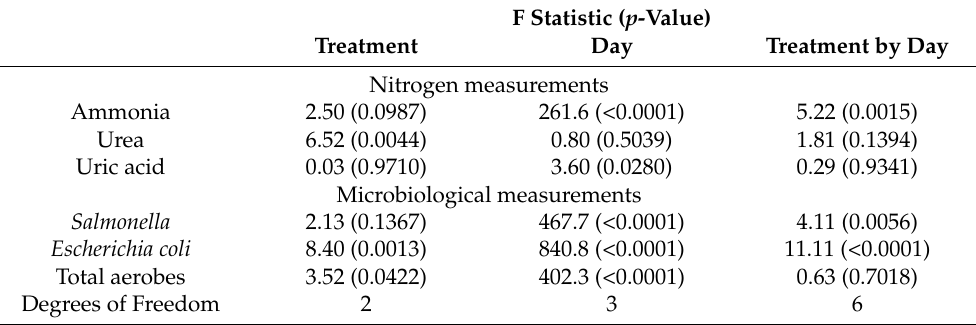
Table 2. Analysis of variance results for effects of hops treatments, day of compost, and their inter- actions on nitrogen and select microbiological populations after 14 days of simulated composting of a 3:1 mixture of wood chip poultry litter mixed without (Experiment 2) or with ground bluestem hay (Experiment 3) 1 .